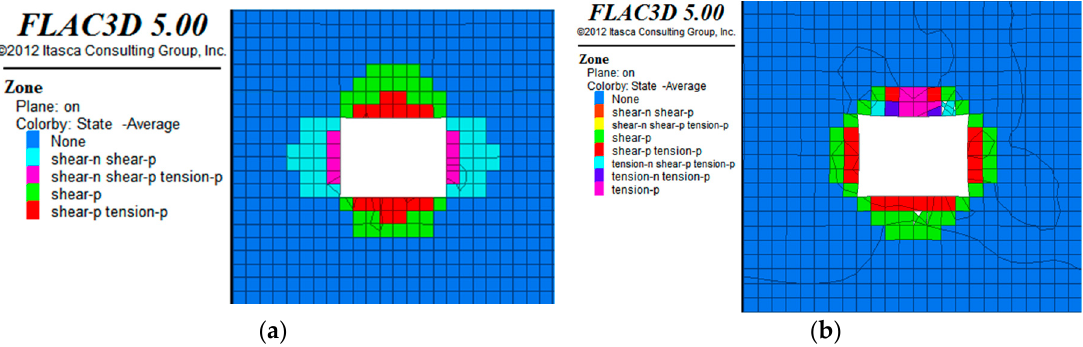
Figure 12. Nephogram of the plastic zone with or without bolt support. ( a ) Without bolt support; ( b ) With bolt support.